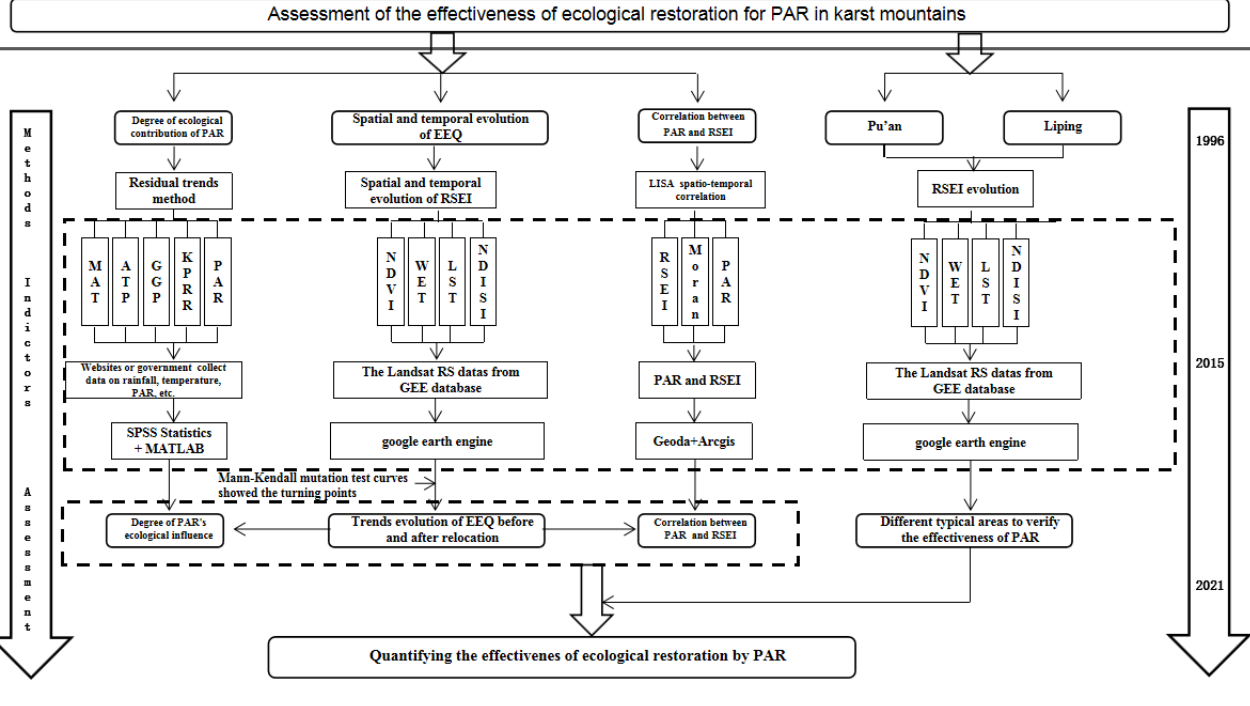
Figure 3. Technical roadmap in the paper.